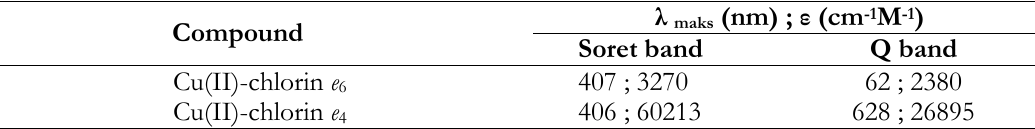
Figure 5. Absorption spectrum of Cu(II)chlorin e 4 (left) and Cu(II)chlorin e 6 (right) in dichloromethane Table I. Molar absorptivity (ε) and λ maks of the compound Cu(II)chlorin e 4 and Cu(II)chlorin e